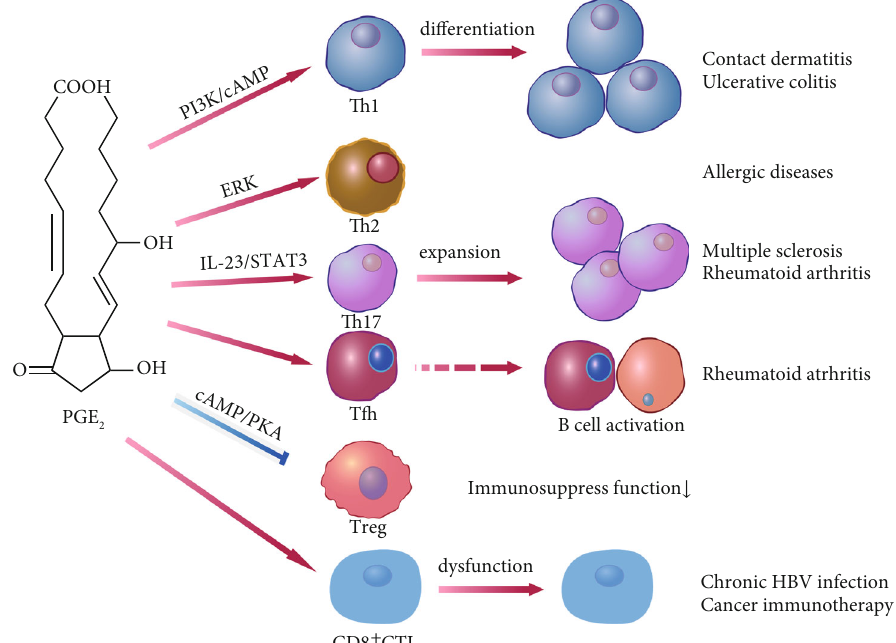
Figure 3: Regulation of T cell subsets by PGE . PGE activates the di ff erentiation of Th1 cells by decreasing the levels of cAMP; PGE 2 2 enhance the IL-4/IFN- γ ratio in CD4 + T cell culture and regulates CD4 + T cell polarization towards Th2 cells; PGE di ff erentiation of naïve CD4 + T cells into Th17 cells via the EP2 or EP4 receptor and cAMP pathway; PGE suppresses the EP/cAMP/PKA pathway and inhibits Treg cell di ff erentiation; PGE di ff erentiation; PGE 2 CTLs and the survival of patients receiving cancer